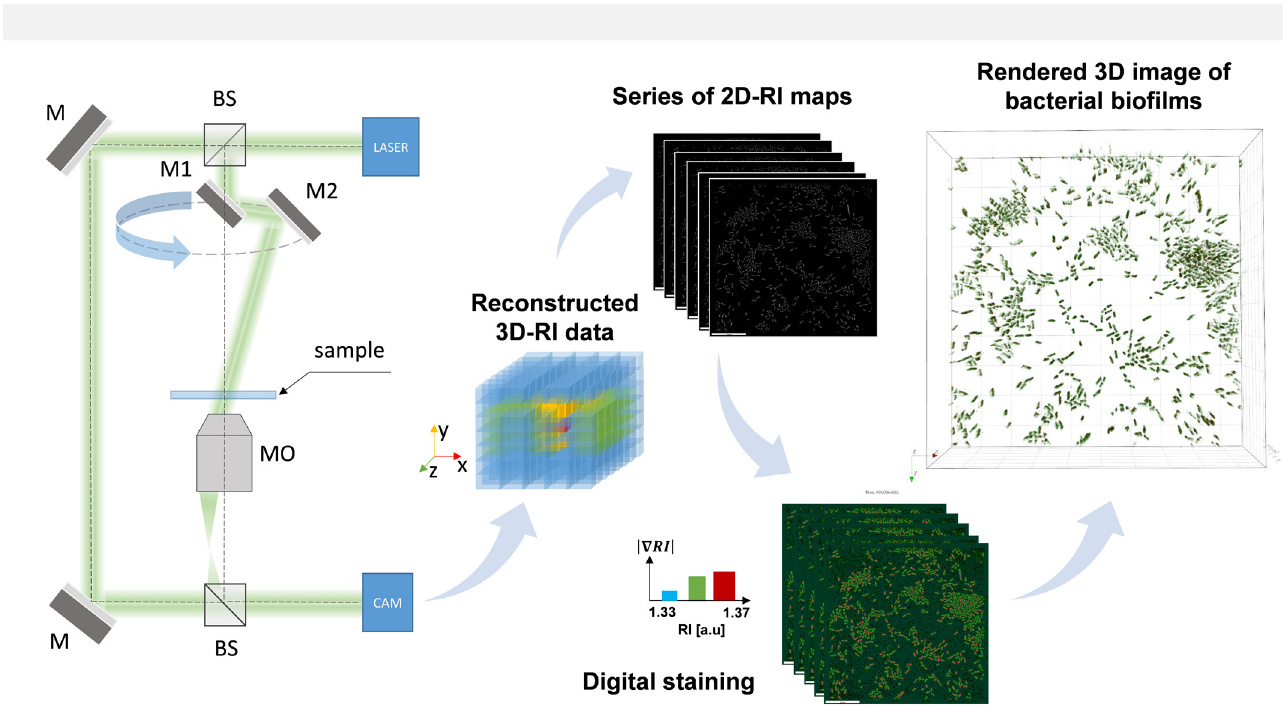
Figure 9. The schema of the experimental system and the RI data processing. M, flat mirrors; BS, beam splitters; MO, microscopic objective; M1,M2, mirrors on the rotational arm; CAM, digital camera.